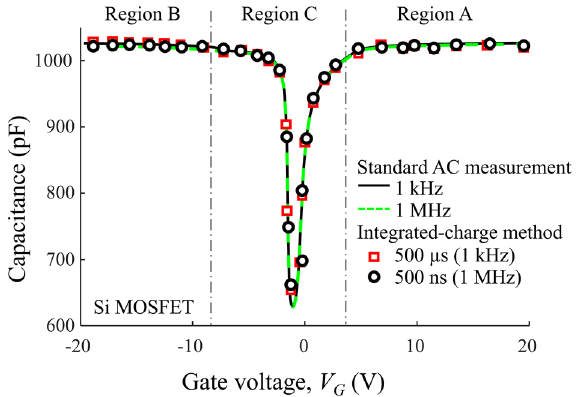
Figure 2. Capacitance–voltage curves for commercial N-channel Si power